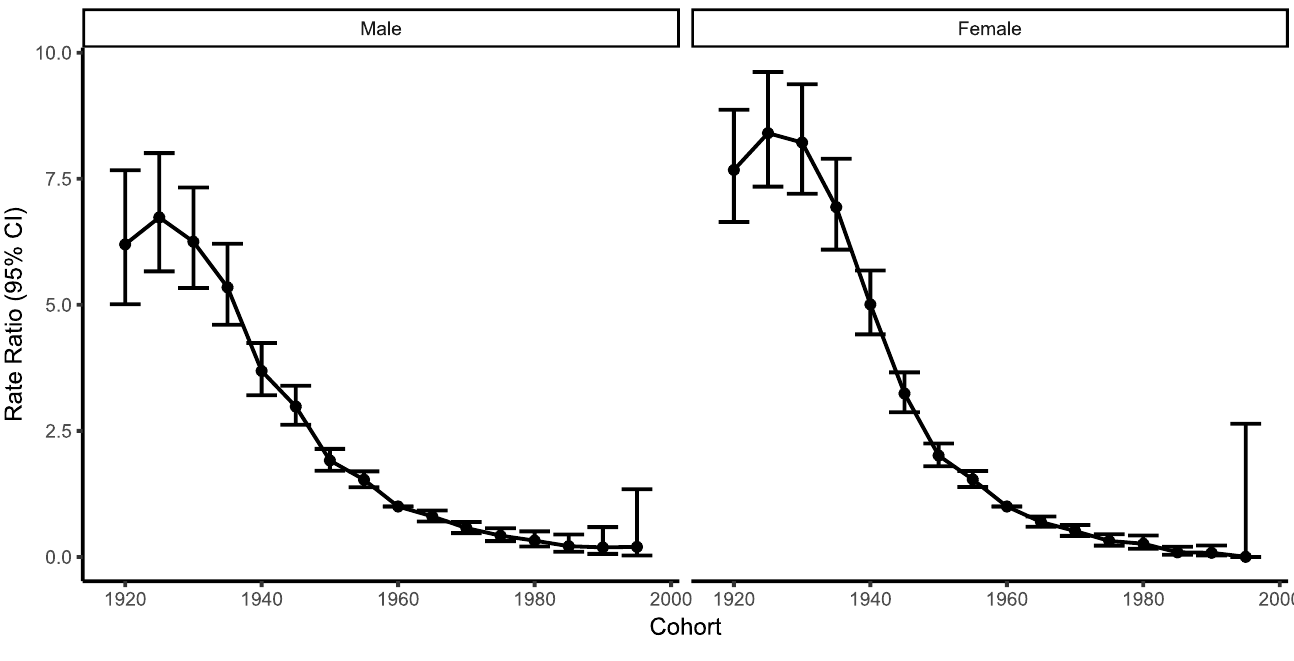
Figure 4. Cohort effects, Male ( left ) and Female ( right ). Cohort relative risk is the ratio of the age- specific rate in each cohort relative to a reference cohort. The wide CI in the youngest cohort is a result of the low number of cases.